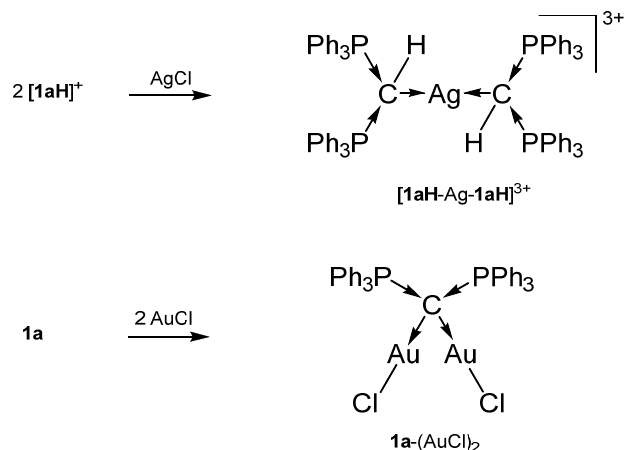
Scheme 3. Selected transition metal compounds with the carbone 1a as four electron donor ligand.